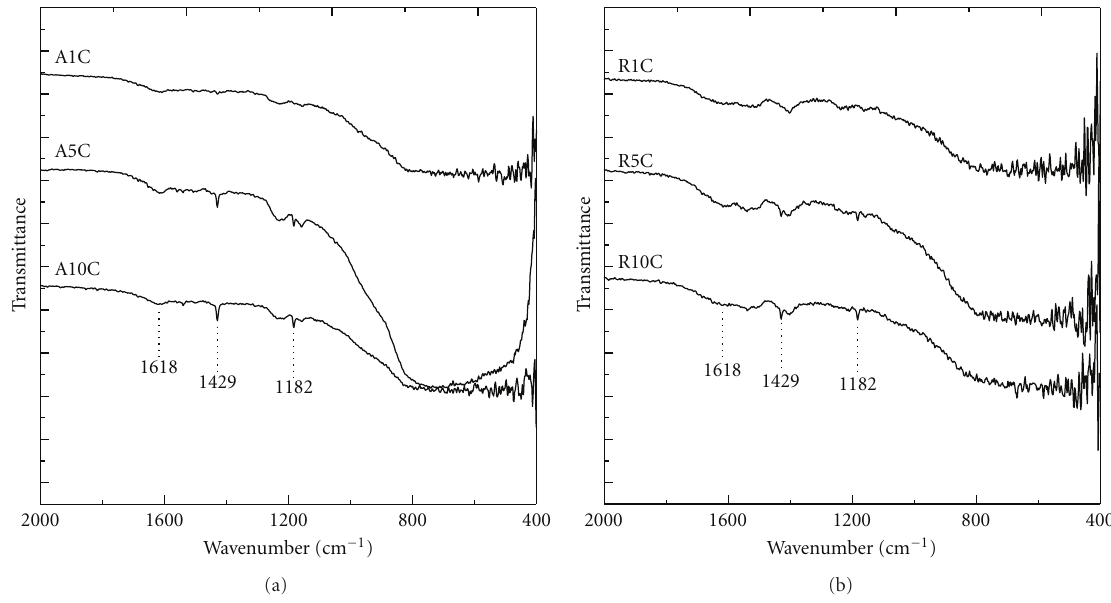
Figure 3: IR spectra of the TiO 2 − C 60 composite samples. (a) the A1C, A5C, and A10C samples, (b) the R1C, R5C, and R10C samples.